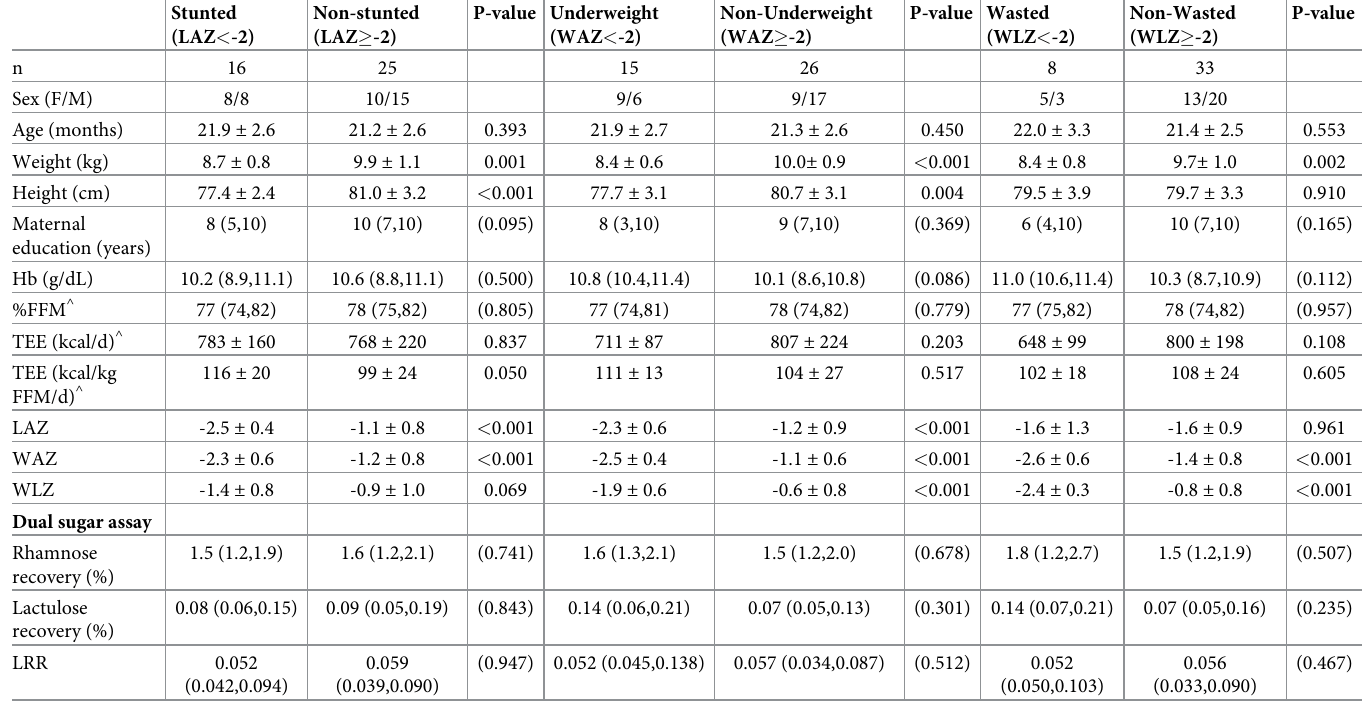
Table 1. Characteristics of children categorised as cases and non-cases by nutritional status �